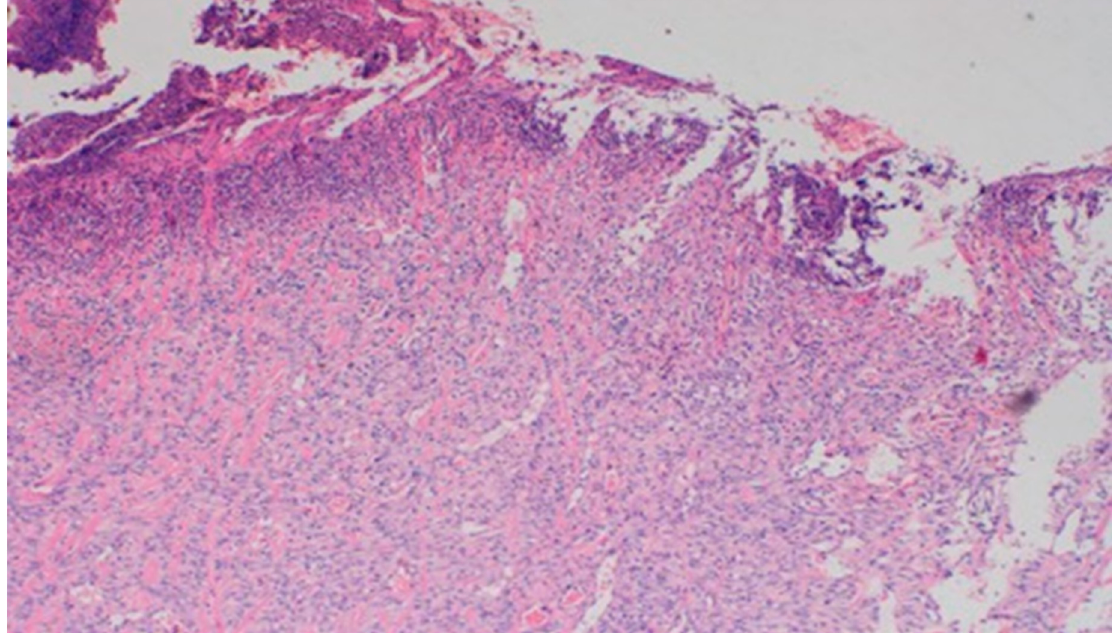
Figure 19. Superficial necrosis. Major neovascularization (40×, H-E) in the wound treated with the 1% nanosilver ointment on day 15.